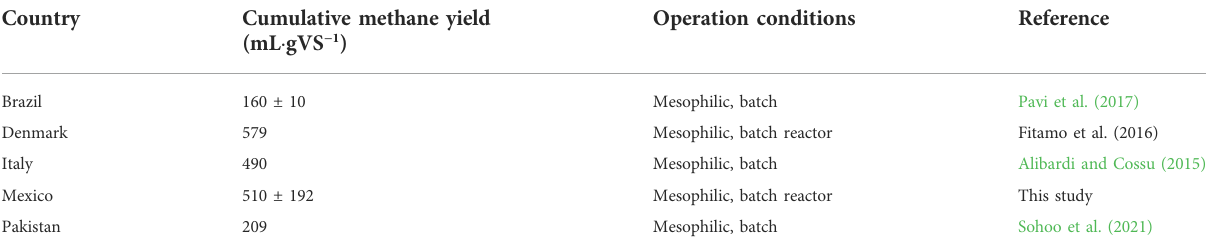
TABLE 3 Comparison of methane yield obtained from the AD of OFMSW in different countries. Country